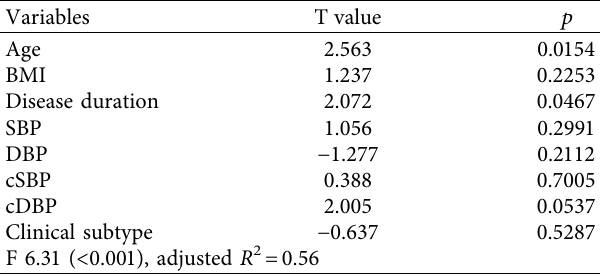
Table 3: Multivariate regression analysis of cfPWV in SSc patients. Variables